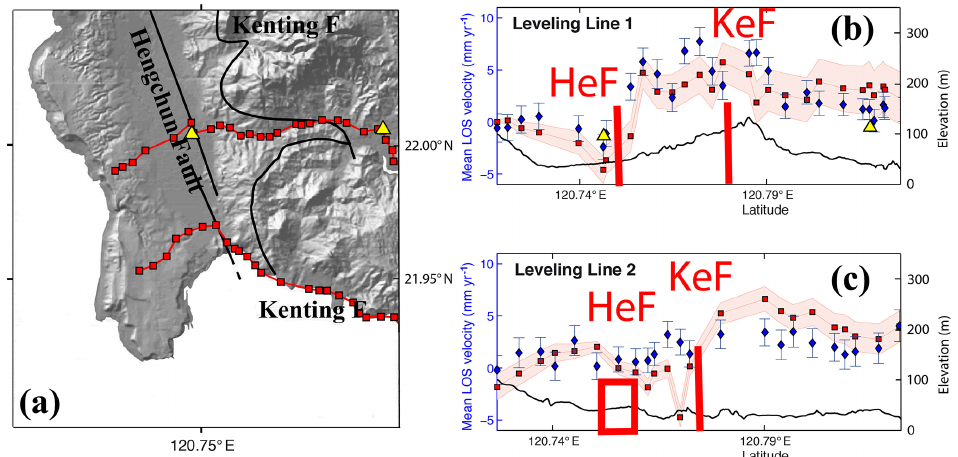
Figure 10. (a) Location of the leveling lines on the Hengchun Peninsula. (b) and (c) Associated PS mean velocity with error bars (blue dots), leveling data (red square and in pink: error bar) and GPS stations data (yellow triangle), projected on LOS. Leveling lines highlight the vertical component of the deformation. The easternmost and westernmost reference points are on an enclosed curve line of the class 1 level reference net defined by Taiwan’s Satellite Survey Center of Department of Land Administration (see SSCDLA, 2018). As leveling line 2 parallels the Hengchun Fault (points 6 to 8), it is represented as a red quadrangle. Note the general agreement of both interseismic leveling and PSI vertical topographic displacements on those two transverse profiles across the whole Southern Hengchun Peninsula. They show subsidence in the western part of the Hengchun Fault (HeF) contrasting with uplifting due to active folding on its eastern side. In addition, there is little significative vertical interseismic displacement on the Kenting Fault location on both profiles during the monitoring time